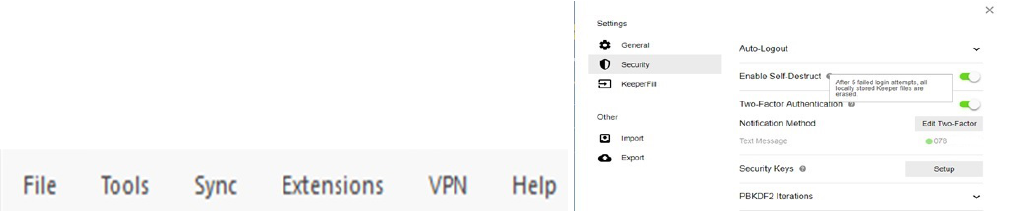
Figure A11. Computer jargon used in Dashlane and Keeper (part of phone number is hidden).